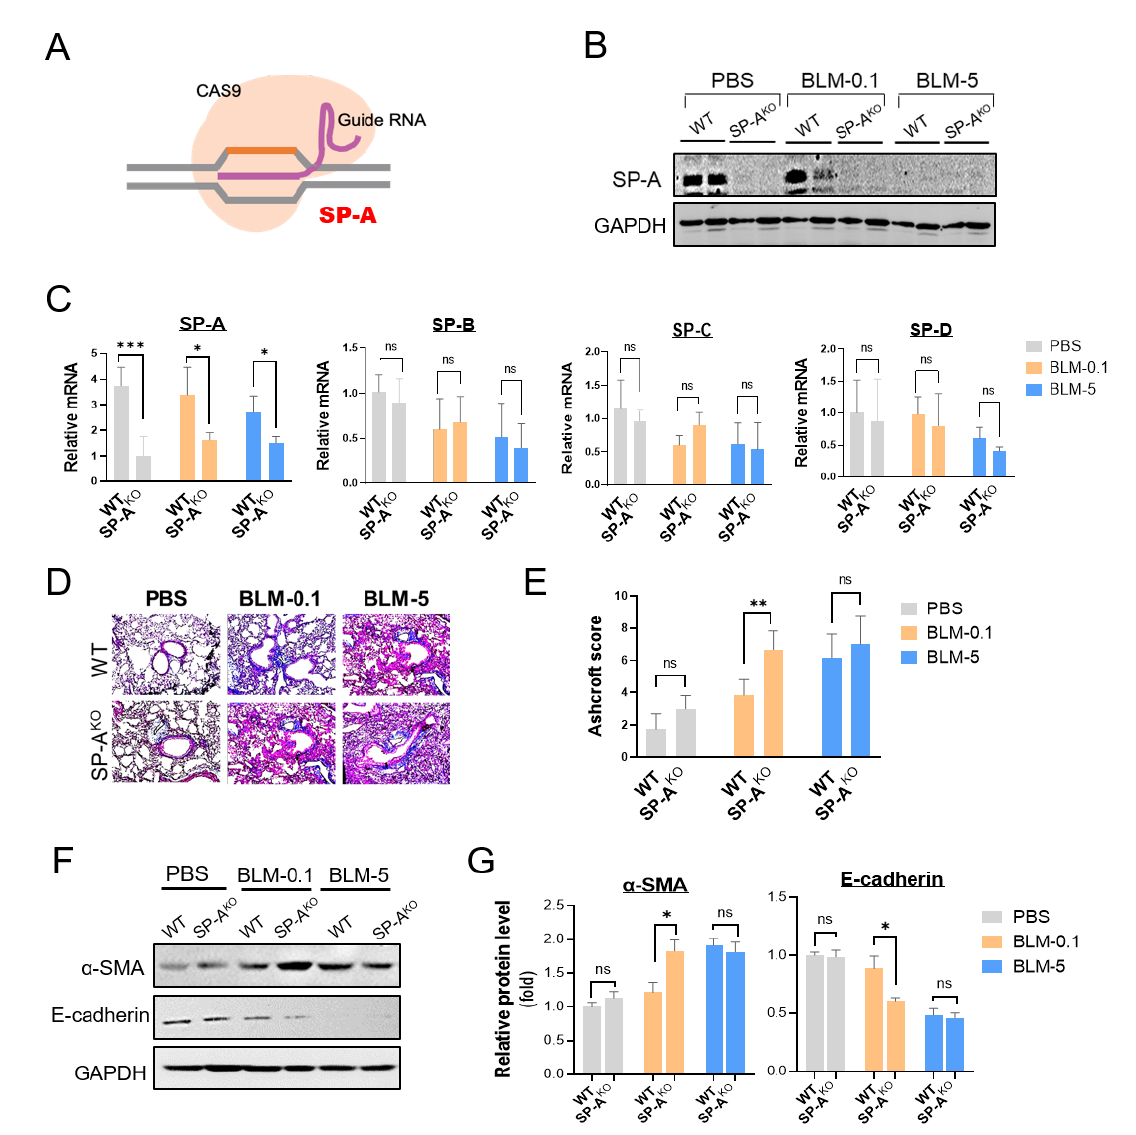
Figure 2. Lung surfactant SP-A deficiency promotes the development of pulmonary fibrosis. ( A ) Schematic showing CRISPR/Cas9-mediated genetic deletion of SP-A. SP-A deletion was performed by intratracheal delivery of lentiviral sgRNA targeting SP-A in CRISPR/Cas9 Rosa26-Cas9 knock-in mice (SP-A KO group). As a control group, WT mice were generated by delivery of control lentivirus sgRNA (WT group). ( B ) Western blot analysis of lung SP-A protein levels in SP-A-deficient mice induced with low-dose BLM (BLM-0.1: 0.1 mg/kg BLM) or high-dose BLM (BLM-5: 5 mg/kg BLM). ( C ) Quantitative real-time qPCR analysis of SP-A, SP-B, SP-C, and SP-D in the lungs of SP-A-deficient BLM-induced mice. The relative level of surfactant protein was normalized to β-actin and calculated as fold change compared to those in PBS-treated WT group. ( D , E ) Representative images and semiquantitative analysis of Ashcroft scoring of Masson’s stained lung tissues from SP-A-deficient BLM-challenged mice. ( F , G ) Western blot analysis of E-cadherin and α-SMA in the lung tissues of mice. Densitometric analysis was represented. The relative level of E-cadherin or α-SMA was normalized to GAPDH and calculated as fold change compared to those in PBS-treated WT group. The data are presented as the mean ± SE. n = 3–6 per group. * p < 0.05, ** p < 0.01, *** p < 0.001. ns indicates no significant difference between groups. WT group: control lentivirus-injected mice; SP-A KO group: mice induced with lentivirus containing sgRNA against SP-A.